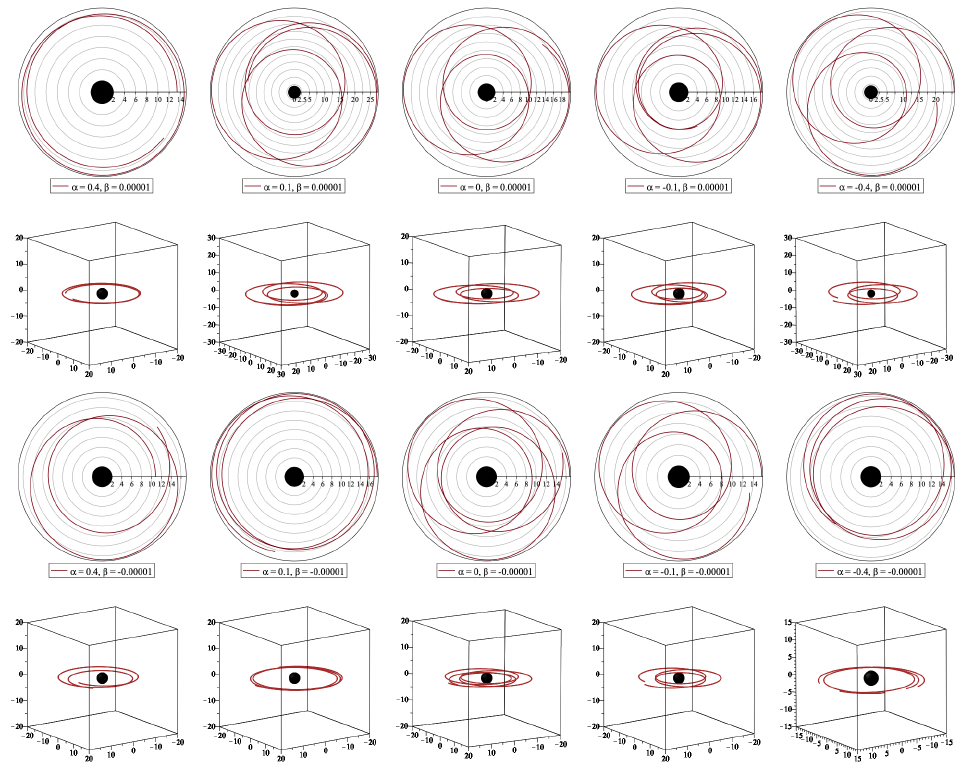
Figure 3 corresponds to the existence of both initial conditions on inner and outer boundaries, where particles trapped in some region form a toroidal shape around the central object. The trajectories for some choices of the parameters are plotted, where a rapid inspection shows that the trajectories of the particle noticeably change when the parameters change.